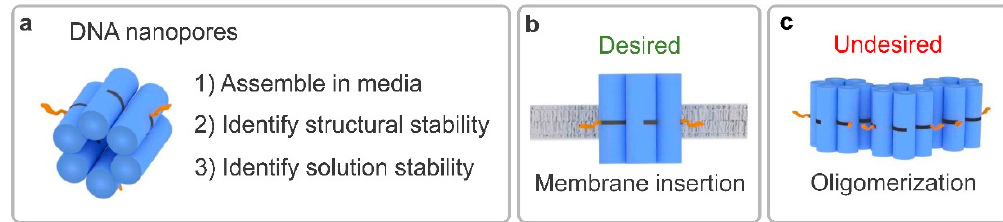
Figure 1. Identifying the formation, structural and solution-phase stability of amphiphilic DNA nanopores in biological media. ( a ) Depiction of six helical bundle nanopore ( blue cylinders ) containing cholesterol lipid anchors ( orange ) and the parameters monitored within; ( b ) the desired monomer membrane binding action in vivo; ( c ) and the undesired hydrophobic lipid anchor-mediated oligomerization which can prevent membrane binding and reduce the active nanopore concentration.